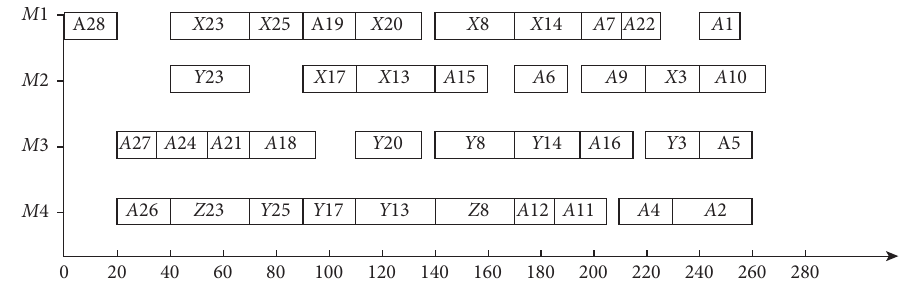
Figure 7: Scheduling results of the time-selective strategy of Multiple-Devices-Process.